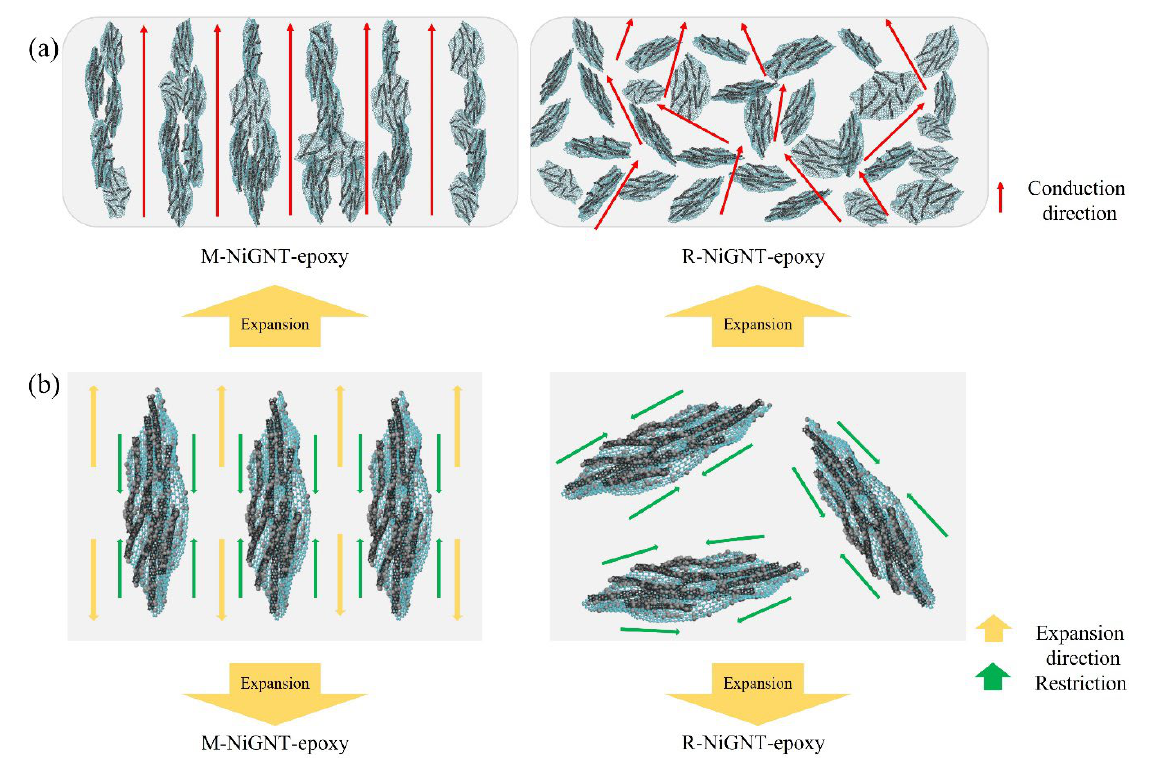
Figure 11. The schematic of conduction ( a ) and expansion ( b ) of the as-prepared